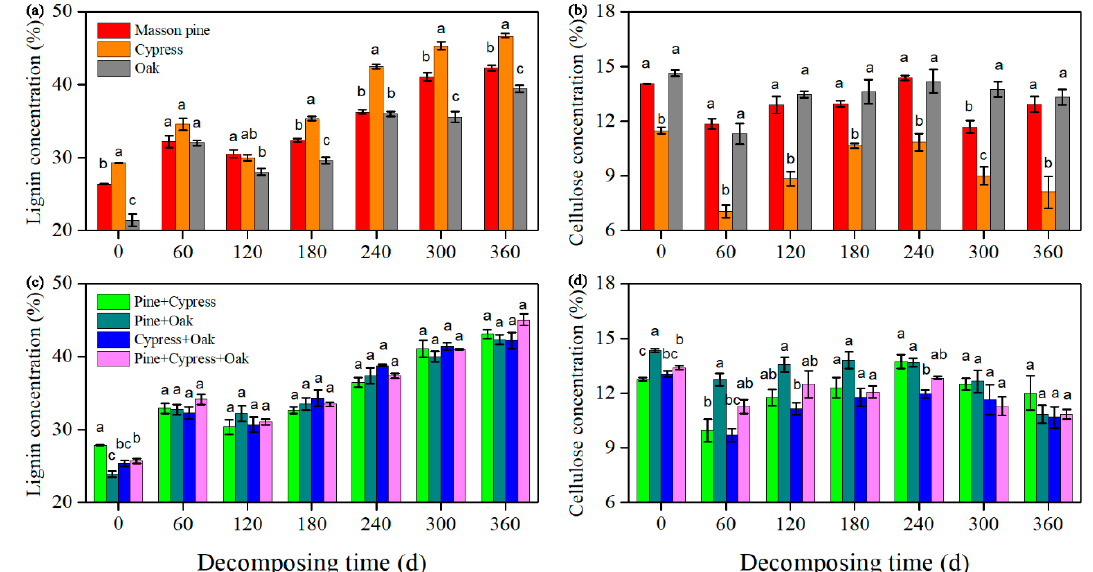
Figure 3. Exponential regression of the lignin concentration (( a ), ( c )) and cellulose concentration (( b ), ( d )) for the treatments (Pine + Cypress, Pinus massoniana + Cupressus funebris; Pine + Oak, Pinus massoniana + Quercus variabilis; and so on) against the decomposition time (mean ± SE, n =